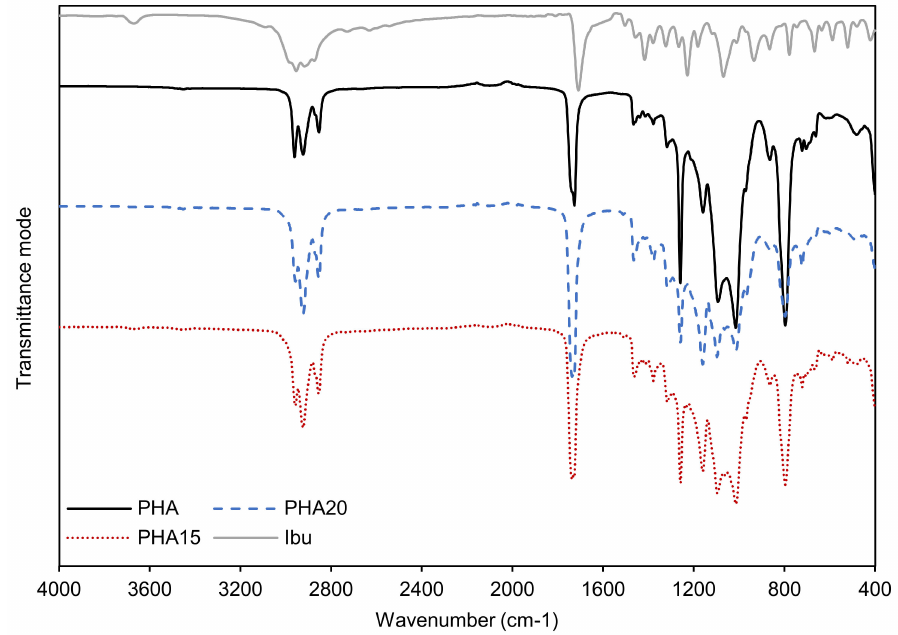
Figure 1. ATR-FTIR spectra of mcl-PHA original sample (PHA, black full line) compared to the mcl-PHA sample impregnated with ibuprofen at 20 MPa (PHA20, blue dashed line) and the sample impregnated at 15 MPa (PHA15, red dotted line). The spectrum for ibuprofen (Ibu, grey full line) is also represented. The spectra were obtained in the region of 4000 to 400 cm − 1 , in transmittance